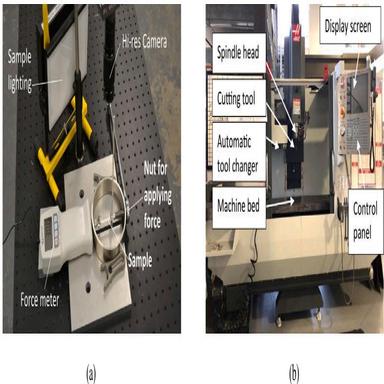
(a) The utilized strain rig for ionizing radiation , and (b) vertical milling machine for machining experiments .